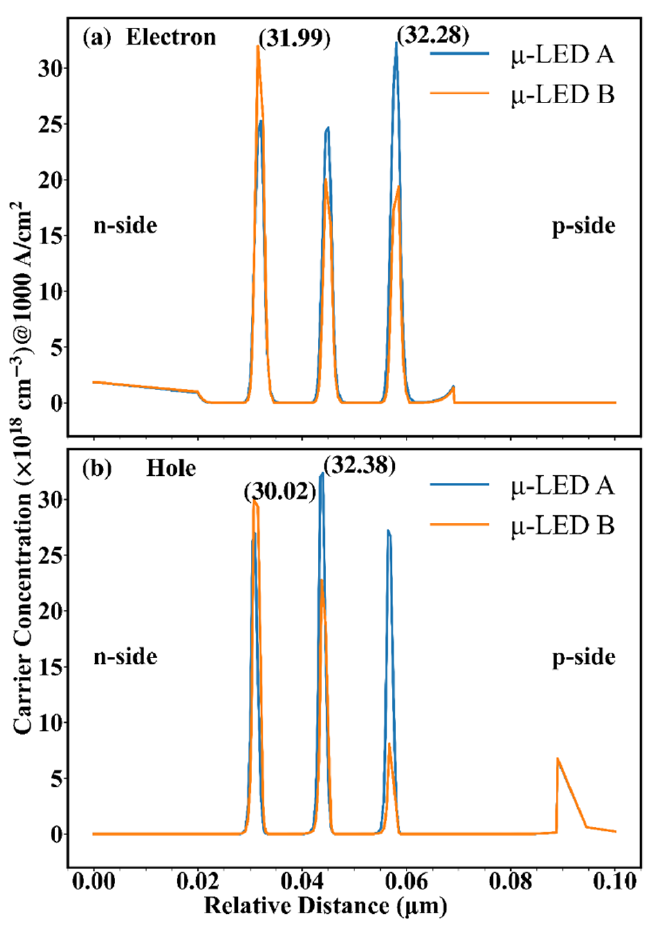
Figure 3. ( a ) Electron distribution and ( b ) hole distribution at 1 kA/cm 2 for μ -LED A and μ -LED B. In order to study the variation rules of carrier concentration, Figure 4 shows the energy band as a function of relative distance for the two µ -LEDs at 1 kA/cm 2 . The Φ is used to represent the energy gap between QB and QW, calculated by the difference between the peak energy of the next QB and the energy valley of the QW, reflecting the transport capacity of carriers. The larger the Φ , the higher the barrier of the QB, the harder the carriers escape, and the weaker the carrier transport. In Figure 4, the Φ s are marked at the QW located in the middle position. In the conduction band, it can be found that the Φ of µ -LED B is higher than that of µ -LED A, indicating the stronger electron transport in µ -LED A, which explains the different electron distribution between µ -LED A and µ -LED B in Figure 3. On the contrary, in the valence band, it can be found that the Φ of µ -LED A is higher than that of µ -LED B, indicating the enhanced hole transport in µ -LED B, which explains the different hole distribution between µ -LED A and µ -LED B in Figure 3. The ∆ E is used to represent the energy gap in the QW, calculated by the difference between the Fermi energy level and the energy valley of the QW, reflecting the confinement ability of carriers. The larger the ∆ E, the easier the carriers are trapped by the QW, and the higher the carrier concentration in the QW. In Figure 4, the ∆ Es are marked at the QW with the highest carrier concentration. It can be found that the ∆ Es of µ -LED A are higher than those of µ -LED B due to the less lattice mismatch in trapezoidal QWs, which explains the higher peaks of the carrier concentration of µ -LED A than those of µ -LED B in Figure